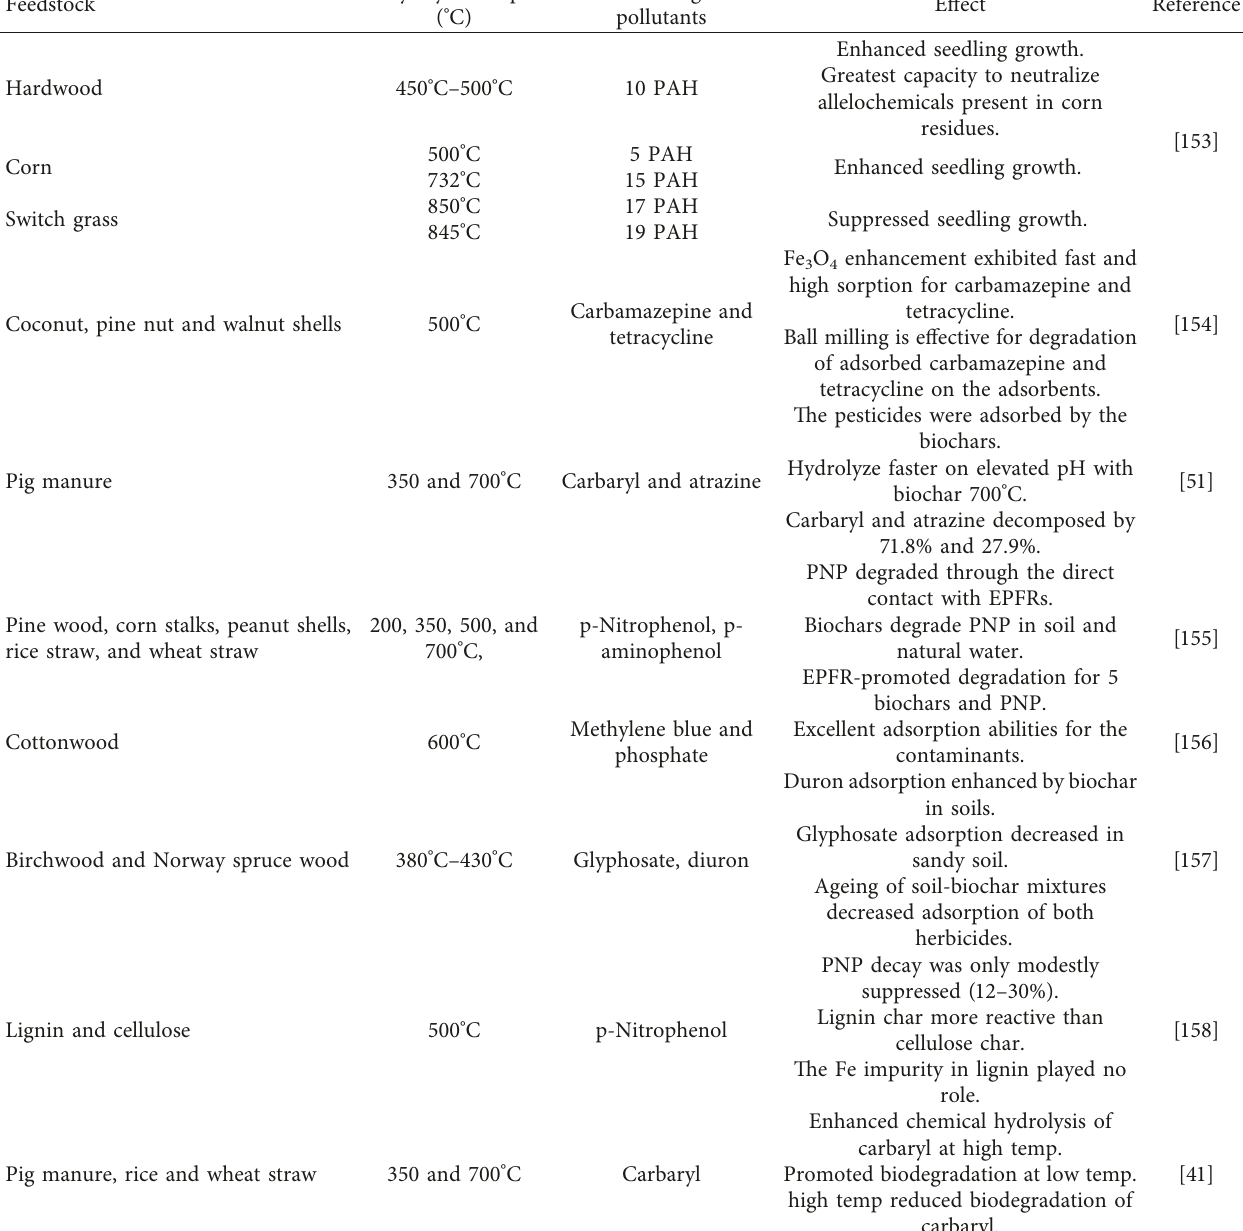
Table 5: Organic contaminant potential and effect of biochar